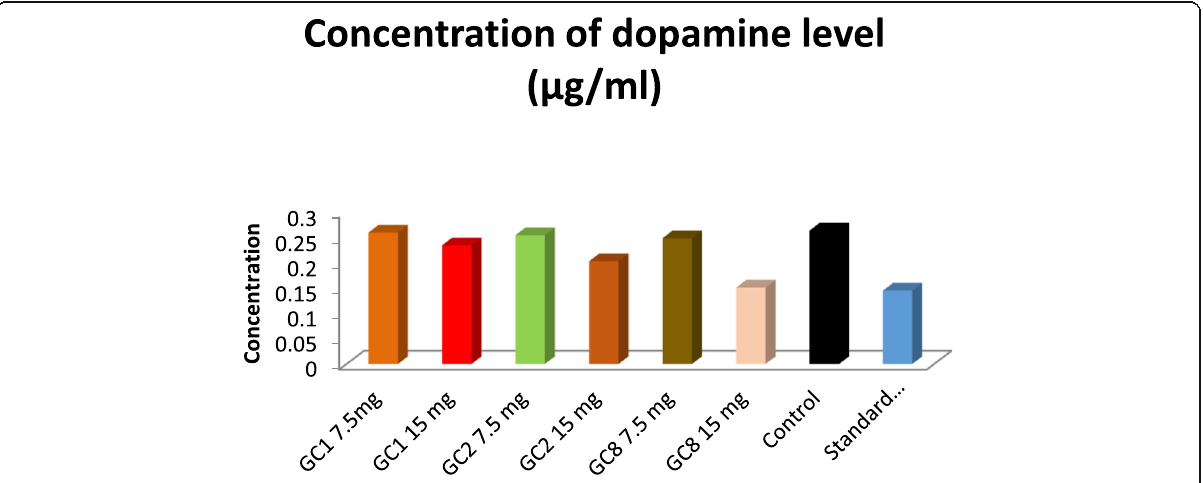
Fig. 4 The concentration level of dopamine in the separated brain after being administered with synthesised compounds/chlorpromazine/1% CMC